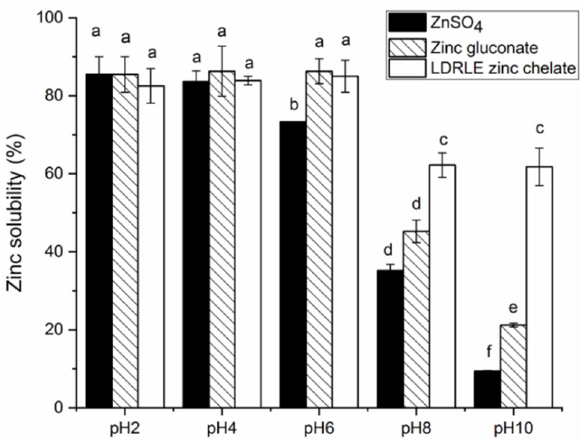
Figure 8. Zinc solubility stability of LDRLE-zinc chelate, zinc sulphate and zinc gluconate under different pH values at 37 °C for 20 min. Different lowercase letters (a–f) above the bars or near the lines indicate significant differences ( p < 0.05).